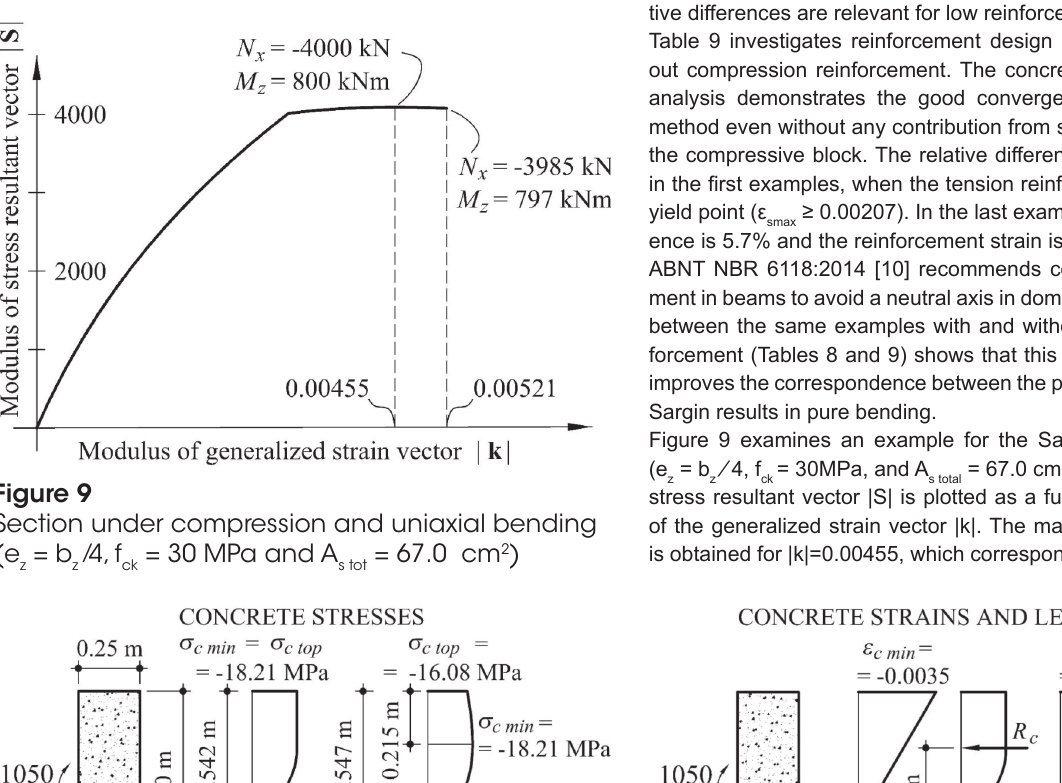
The examples in Tables 2, 4, and 6, which consider combined compression and bending with smaller eccentricity, yield significant relative differences. A relative difference of -9.0% is found for C15